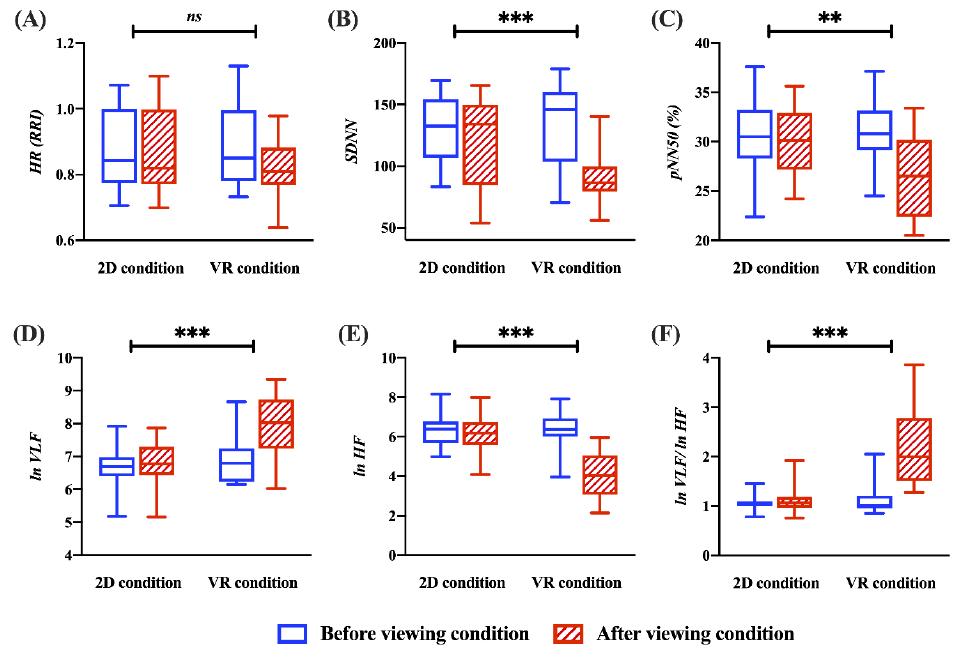
Figure 4. Representation of cardiac activity for MS between the 2D and VR conditions based on the ANCOVA test (*** p < 0.001 and ** p < 0.0083). ( A ) RRI (heart rate). ( B ) SDNN. ( C ) pNN50. ( D ) ln VLF. ( E ) ln HF. ( F ) ln VLF/ ln HF ratio.